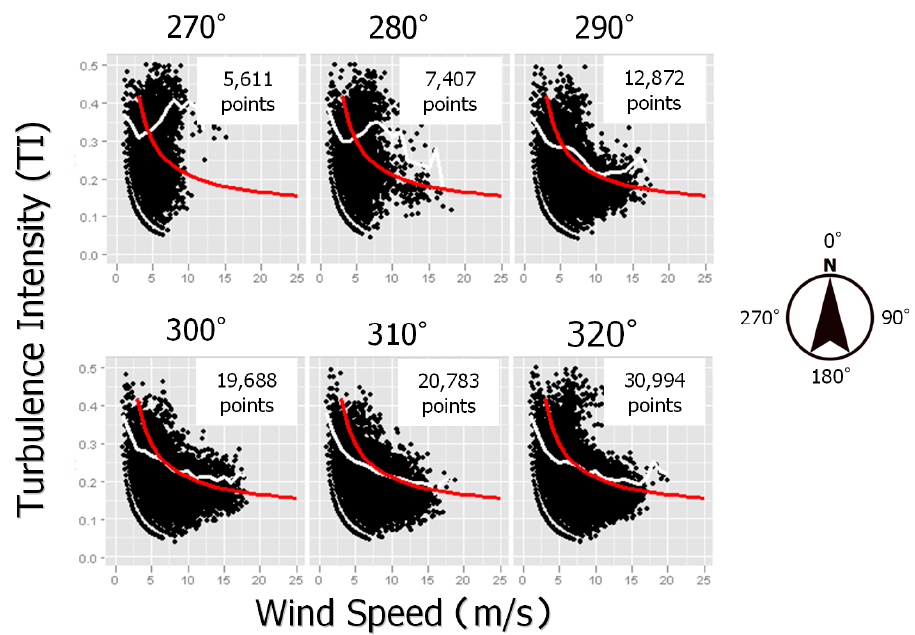
Figure 6. TI at T7 in westerly to north-westerly wind. The plot in the upper left panel is for a wind direction of 270°, and the plot in the lower right panel is for a wind direction of 320°.